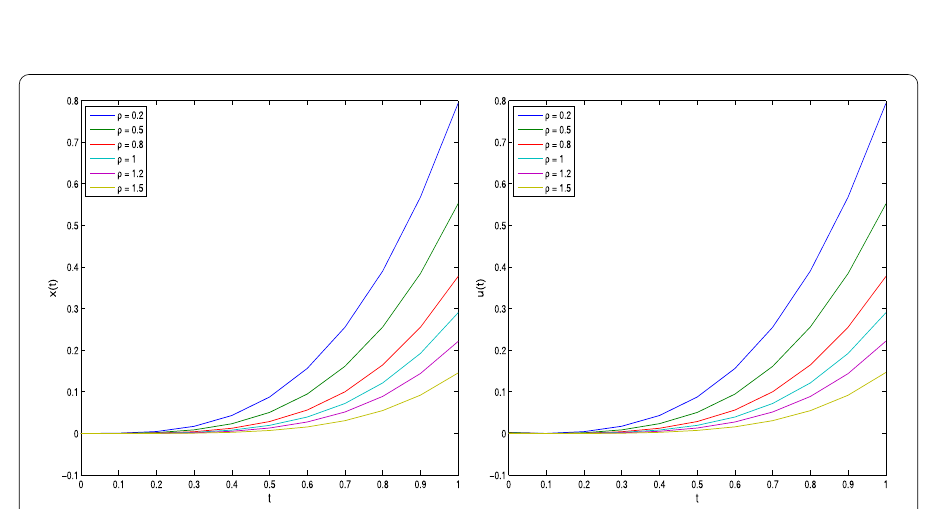
Figure 5 The approximate state x ( t ) (left) and the approximate control u ( t ) (right) at various values of ρ and α = 0.9, N =